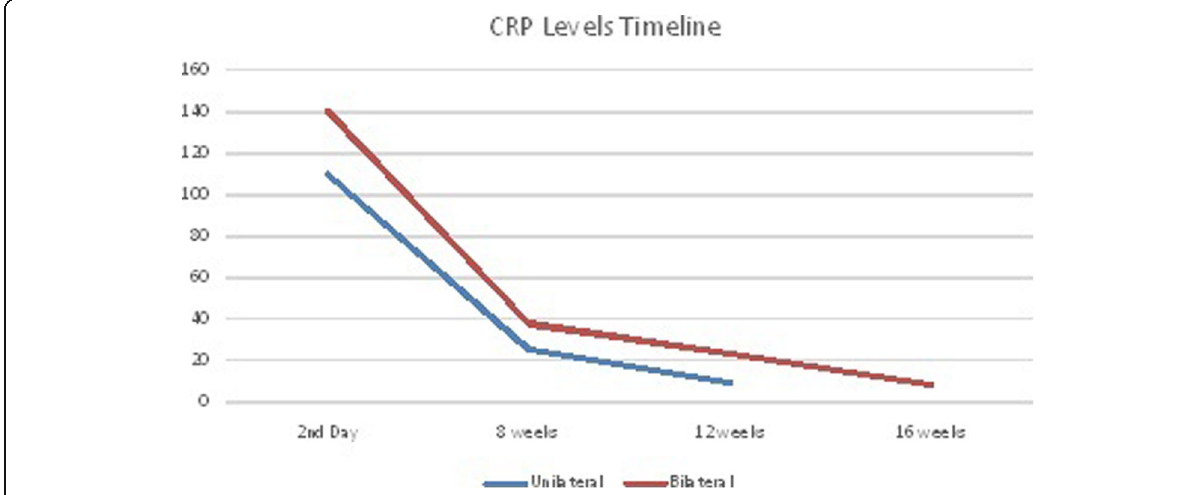
Fig. 1 CRP Levels Timeline for Unilateral and Bilateral